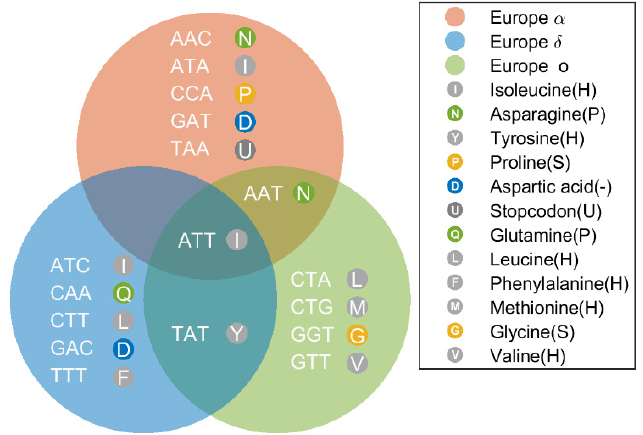
Figure 11. Highly conserved mutations identified in SARS-CoV-2 genomes from China, the USA and Europe. The mutation ATT(I) occurred in high-HGS populations in all the three